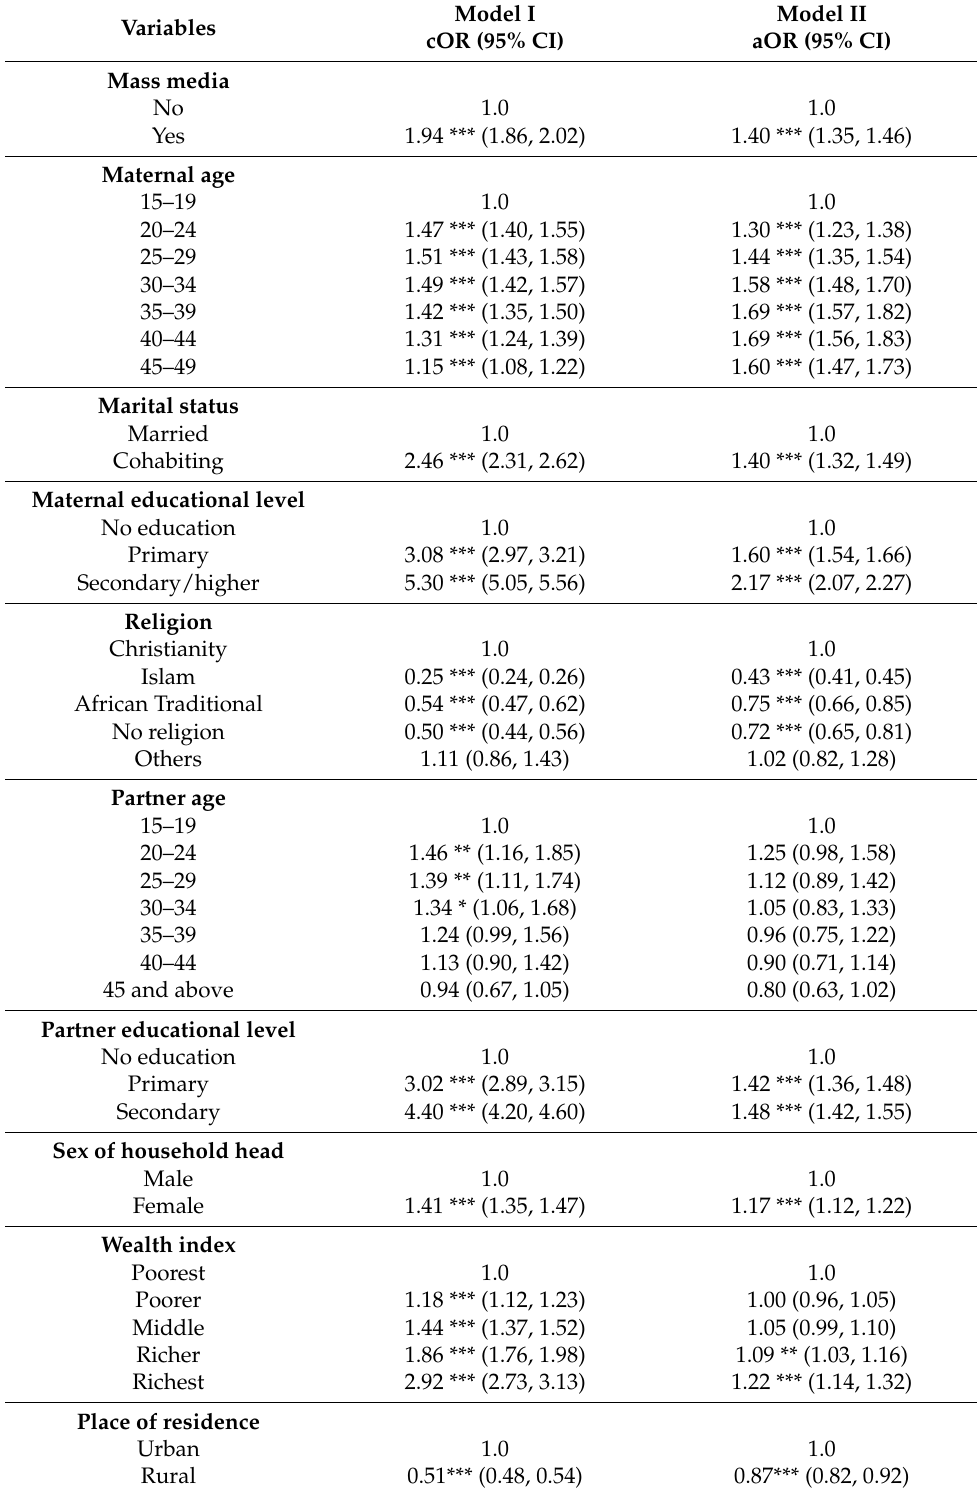
Table 4. Binary logistic regression analysis of mass media, covariates, and safer sex